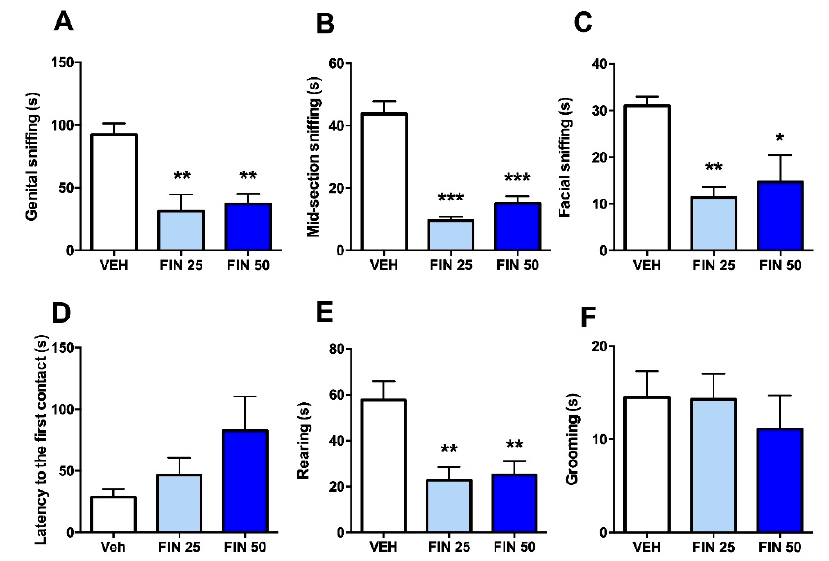
Figure 3. Finasteride (FIN) reduced social interaction with foreign social counterparts. When encountering foreign rats, FIN-treated rats exhibited significant reductions in the duration of genital ( A ), mid-section ( B ), and facial sniffing ( C ), but no changes in the latency to the first social approach, n = 9/10/group ( D ). In addition, FIN reduced rearing ( E ), but not grooming responses ( F ). * p < 0.05, ** p < 0.01, *** p < 0.001 in comparison to rats treated with vehicle (VEH). Doses of FIN are indicated in mg/kg